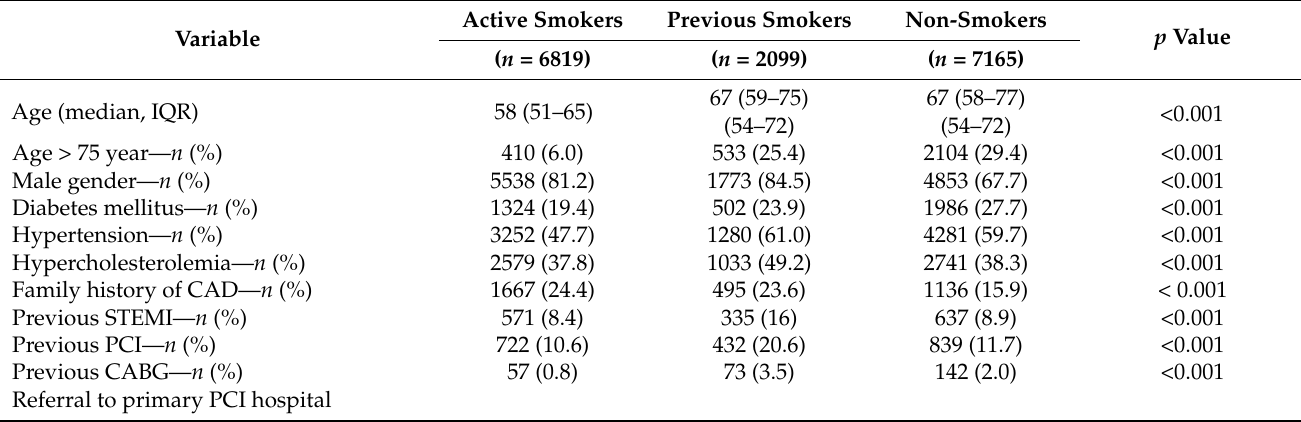
Table 1. Baseline demographic and clinical characteristics according to smoking